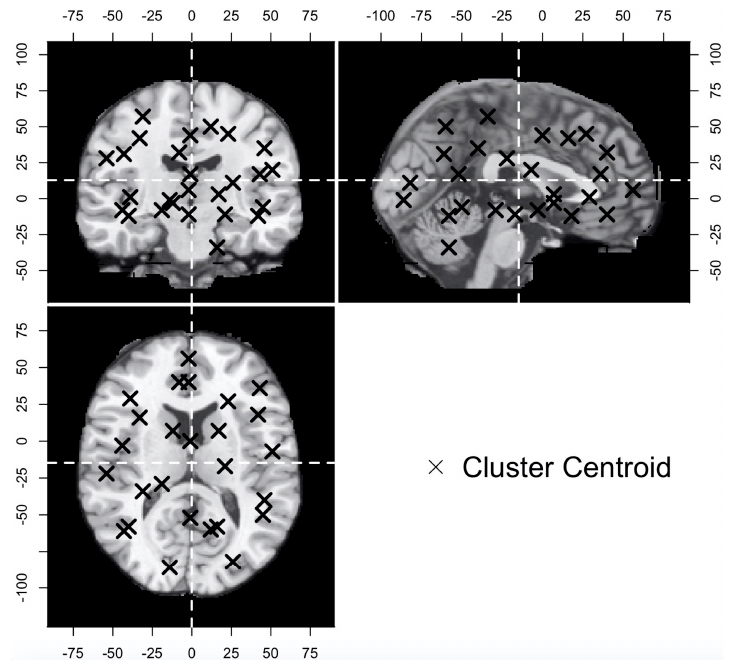
Figure 6. Results of k-means clustering. top left = coronal view; top right = sagittal view; lower right = axial view. Table 4. Results of chi-square